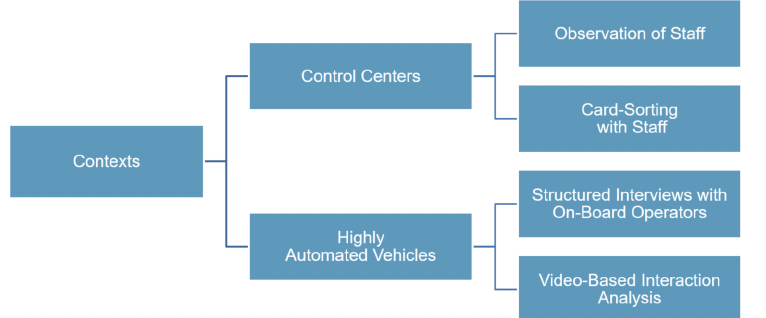
Figure 4. Contexts from which scenarios were extracted and methods used in the